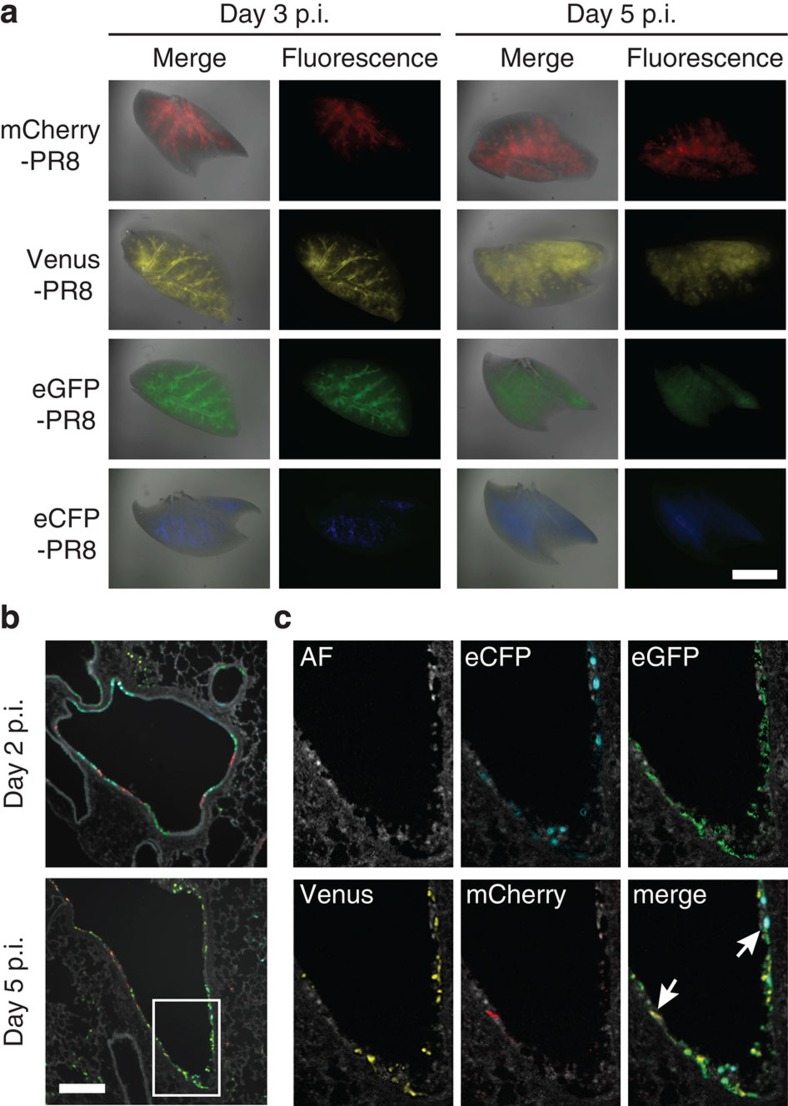
Distribution of Color-flu viruses in lungs.(a) Lung tissues were harvested from B6 mice at days 3 and 5 p.i. with Color-flu viruses (105 PFU of MA-eCFP, eGFP, Venus and mCherry-PR8). Whole-mount images of transparent lung tissues were obtained by using a fluorescent stereomicroscope. Scale bar, 5 mm. (b,c) B6 mice were intranasally inoculated with a mixture of MA-eCFP, eGFP, Venus and mCherry-PR8 (2.5 × 104 PFU per strain). (b) The sections of lungs at days 2 and 5 p.i. were analysed by using an inverted fluorescence microscope with a Nuance FX multispectral imaging system with inForm software. Scale bar, 100 μm. (c) Enlarged images of the indicated area in (b) were unmixed and separated into autofluorescence (AF), eCFP, eGFP, Venus and mCherry fluorescence. Arrows in the merged image indicate cells infected with different colour variants of Color-flu viruses.